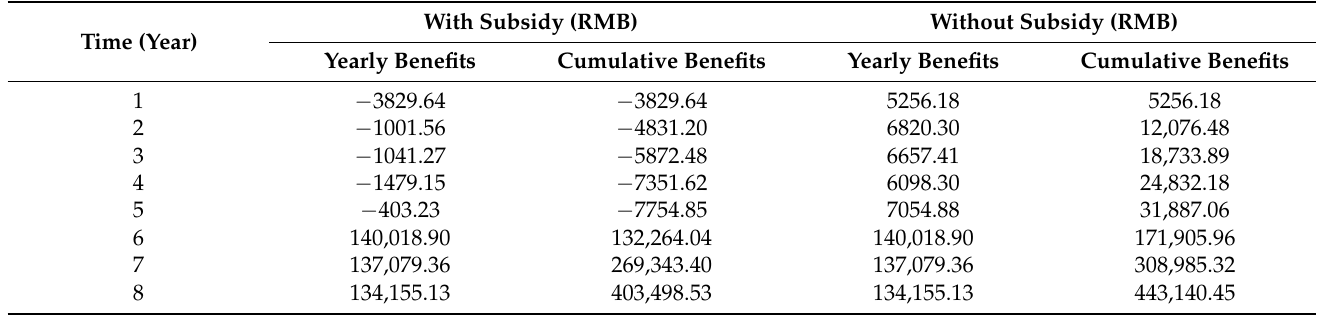
Table 5. Benefits of planting H. ammodendron with and without the afforestation